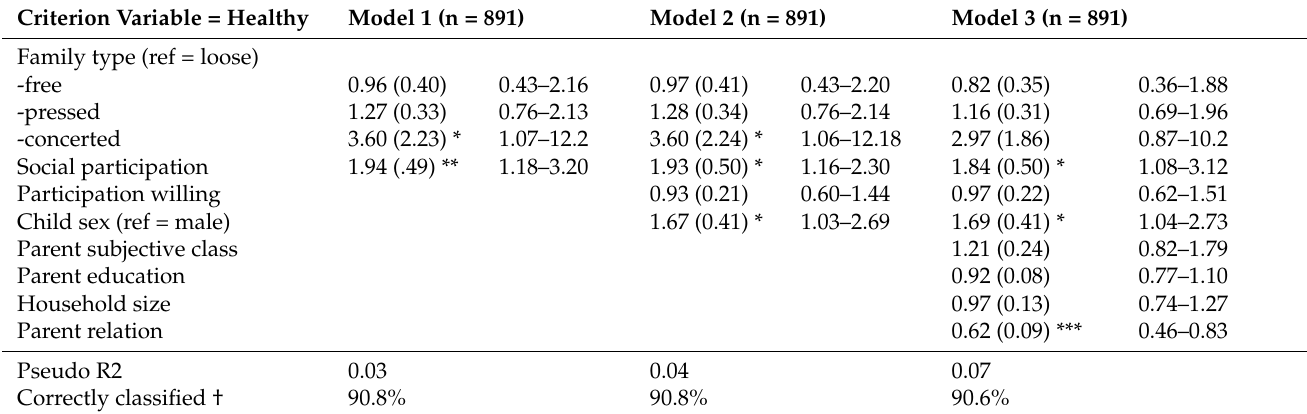
Table 5. Logistic regression results in odds ratios with standard errors and 95% confidence